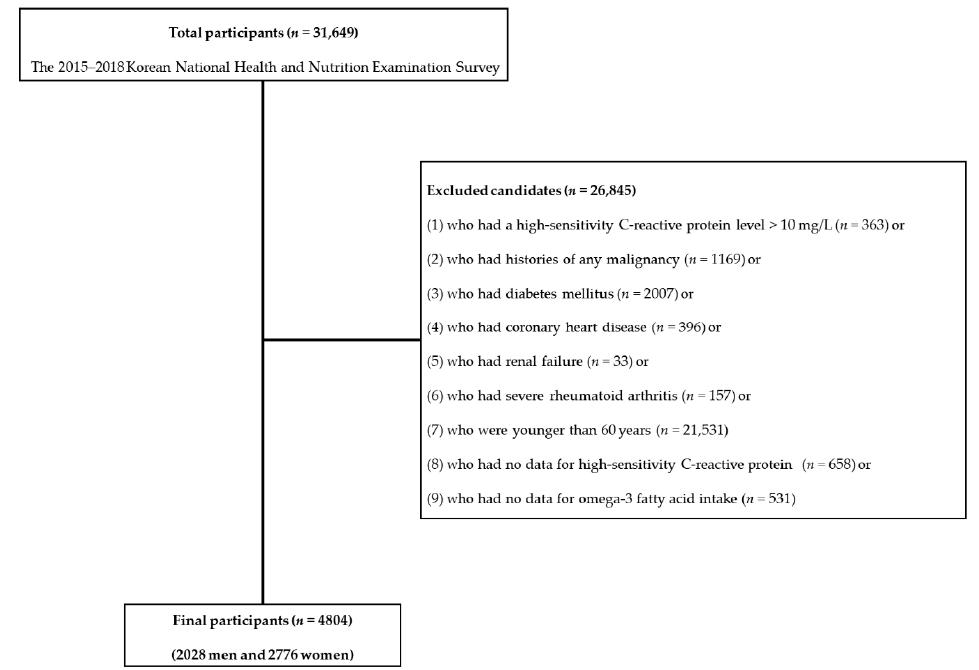
Figure 1. Flowchart of exclusion criteria.